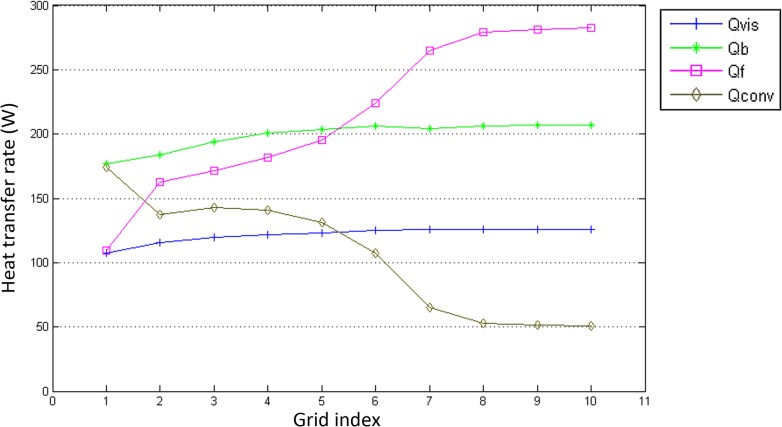
Results of the grid independence calculation.